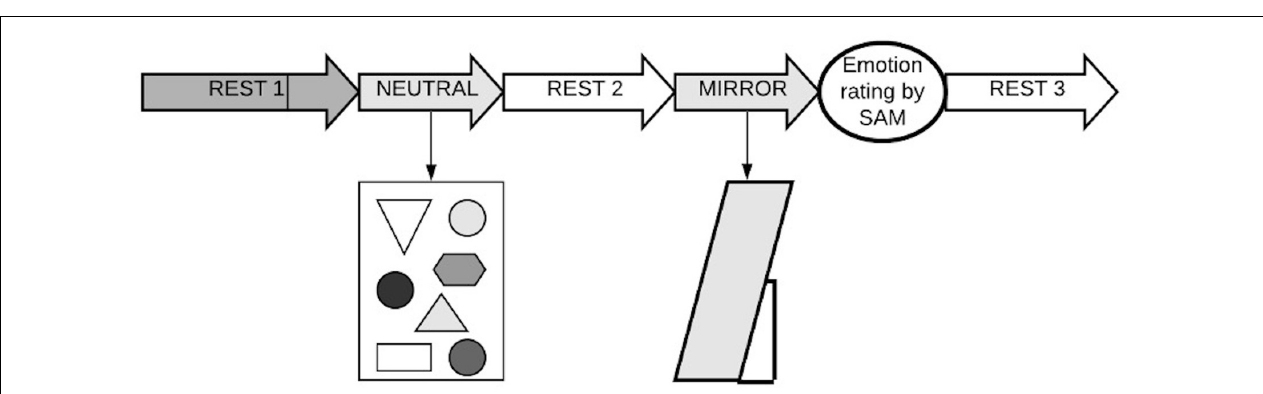
FIGURE 2 | The experimental design in the present study. REST 1 = last 1 min from a 3-min rest period; NEUTRAL = 30 s neutral condition (“vanilla baseline”); REST 2 = 1-min rest after neutral condition, MIRROR = 30 s mirror exposure, SAM, Self-Assessment Manikin scale, REST 3, 1-min rest after mirror exposure period.